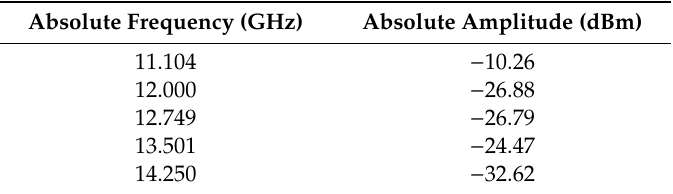
Figure 6. Snapshot of actual Measat3 signal ( a ) measured on Digital Satellite meter and ( b ) signal spectrum. Table 5. Receiver transponders and their power level.